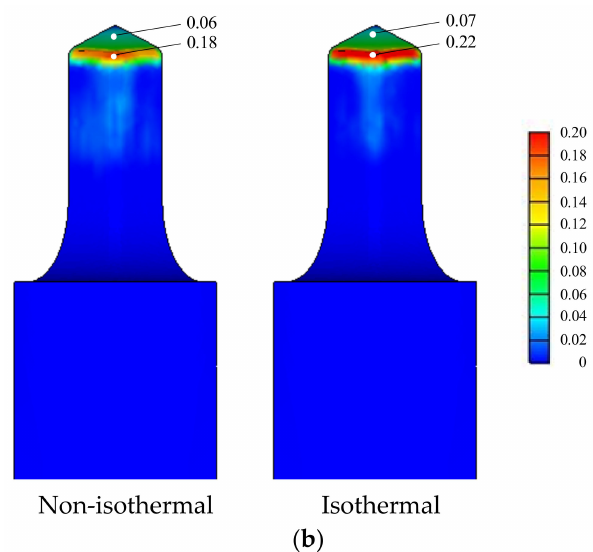
Figure 13. The die fatigue life cycles and wears predicted by non-isothermal and isothermal analyses: ( a ) die fatigue life cycles; ( b ) die wears.